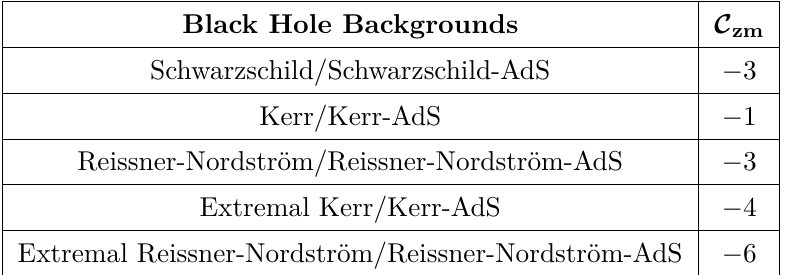
Table 3. C zm contributions for the 4D black holes embedded in EMD-AdS and EMD theories. The results for extremal backgrounds are exclusively induced from their near-horizon